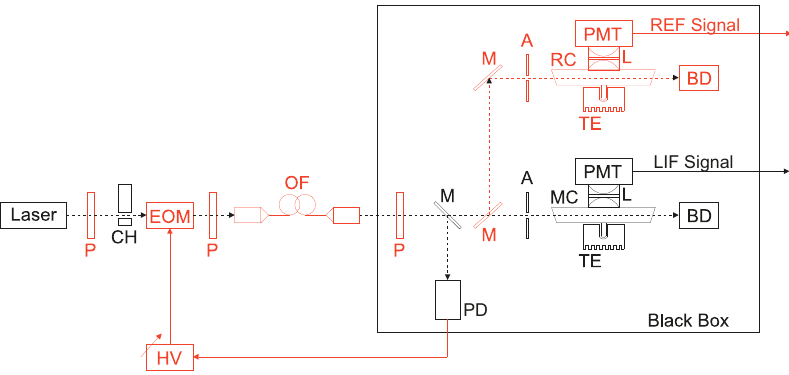
Figure 1. Comparison of original (black color) and upgraded (black + red colors) laser-induced fluorescence experimental setups. The upgrade includes active stabilization of the excitation laser intensity with the help of the electro-optical amplitude modulator (EOM), the monitoring of the spectral condition of the laser source by the reference cell (RC) and the implementation of correction for backscattered light by the procedure of cooling the cell with liquid nitrogen. Laser—502 nm